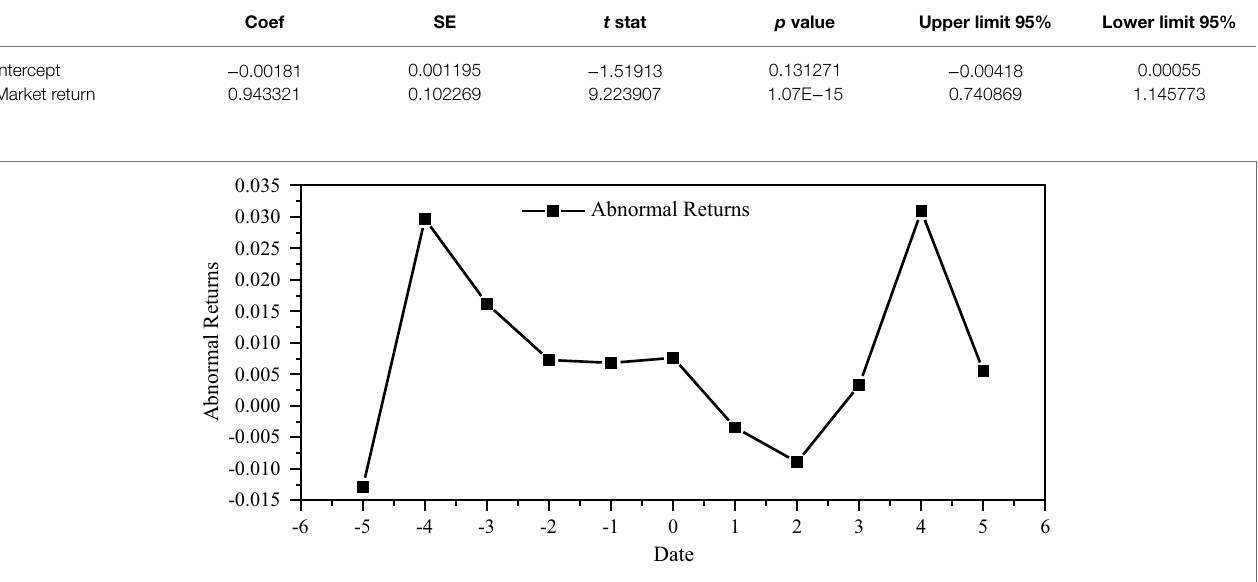
TABLE 17 | Changes in abnormal returns.